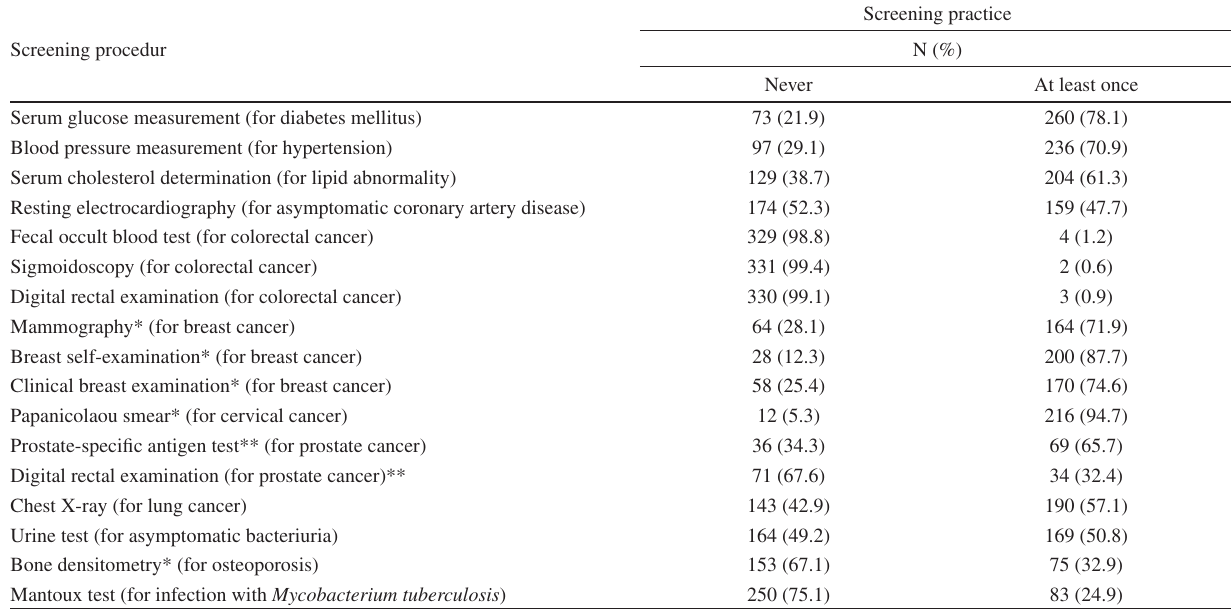
Table 2 - Screening practices among health care workers in a tertiary-care hospital in Sao Paulo, Brazil, 2001-2003